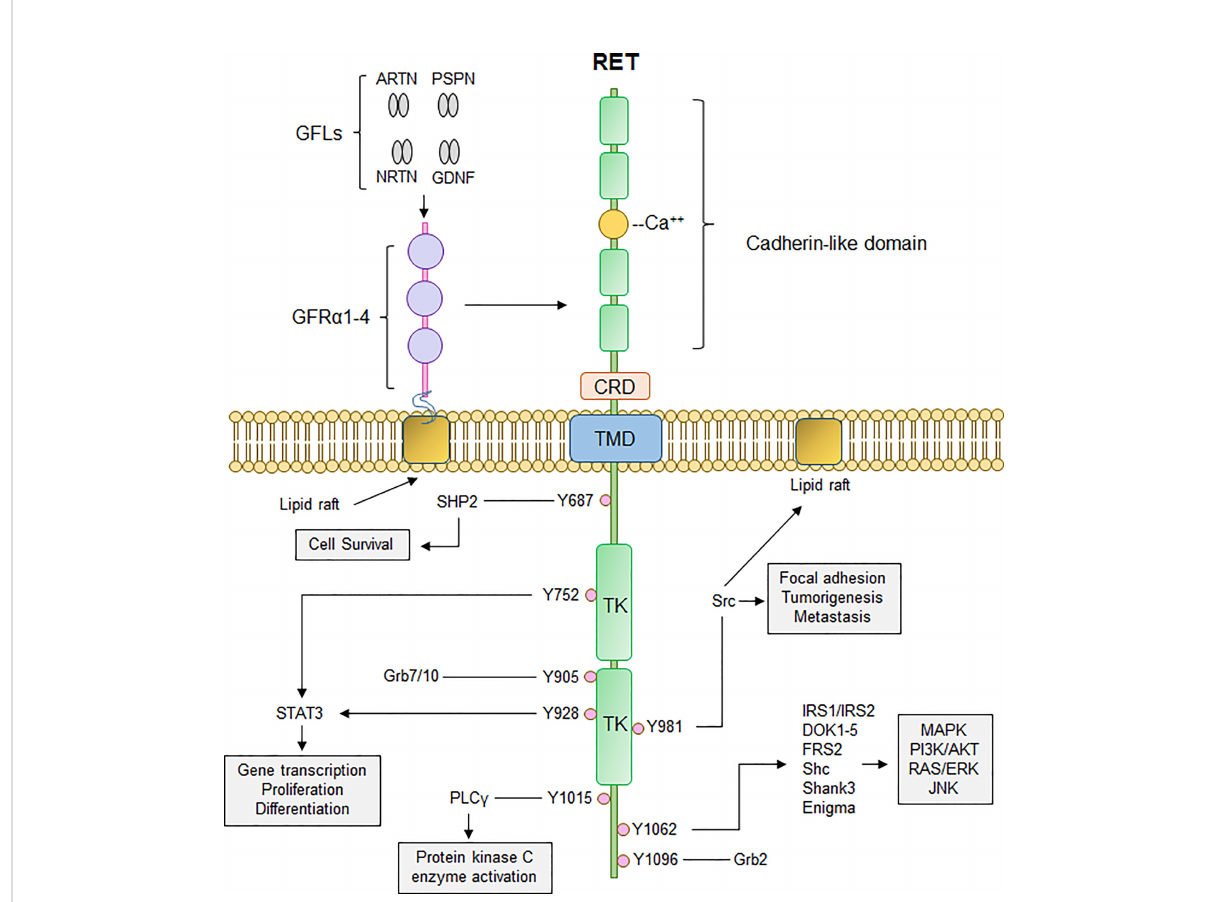
FIGURE 1 Canonical RET signaling. RET activation occurs upon ful fi llment of multiple steps. Binding of GDNF-family ligands (GFLs) such as Artemin, Neurturin, Persephin, (ARTN, NRTN, PSPN, respectively), and GDNF to co-receptor GFR a 1-4, concurrently with binding of calcium ions to the calcium binding domain, induces recruitment of RET, forming RET-GFR a complex. Formation of RET-GFR a complex brings two RET monomers in close proximity to induce homodimerization and crossphosphorylation of key RET tyrosine residues that recruit adaptor proteins important for propagation of RET signaling, such as PI3K/AKT, MAPK, PLC g , and RAS/RAF/ERK. Thus, activation of RET signaling ultimately promotes cell proliferation, growth, and survival through activation of multiple downstream signaling cascades. CRD,